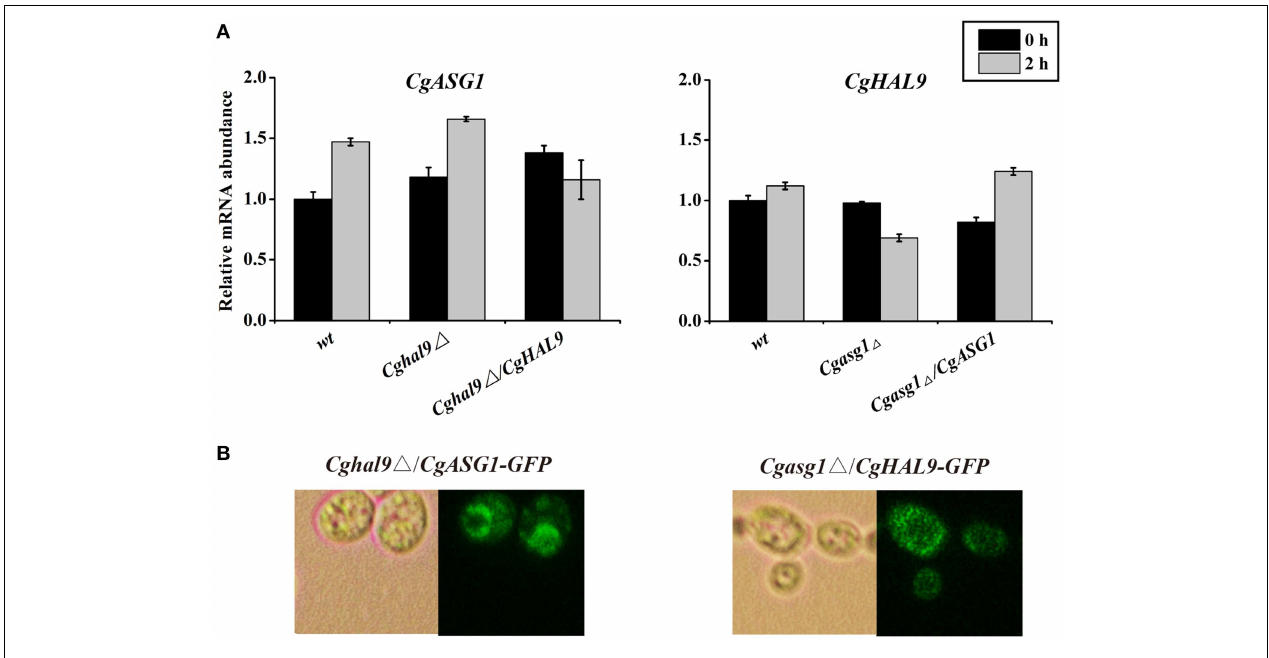
FIGURE 8 | An interaction between CgASG1 and CgHAL9 was tested using quantitative reverse-transcribed PCR (qRT-PCR) and green fluorescent protein (GFP) localization. (A) qRT-PCR was performed on RNA samples of log-phase cells in YNB and YNB-pH 2.0 media to analyze the expression levels of CgASG1 and CgHAL9 in the indicated strains. Results are presented as fold expression relative to the levels of the wild-type